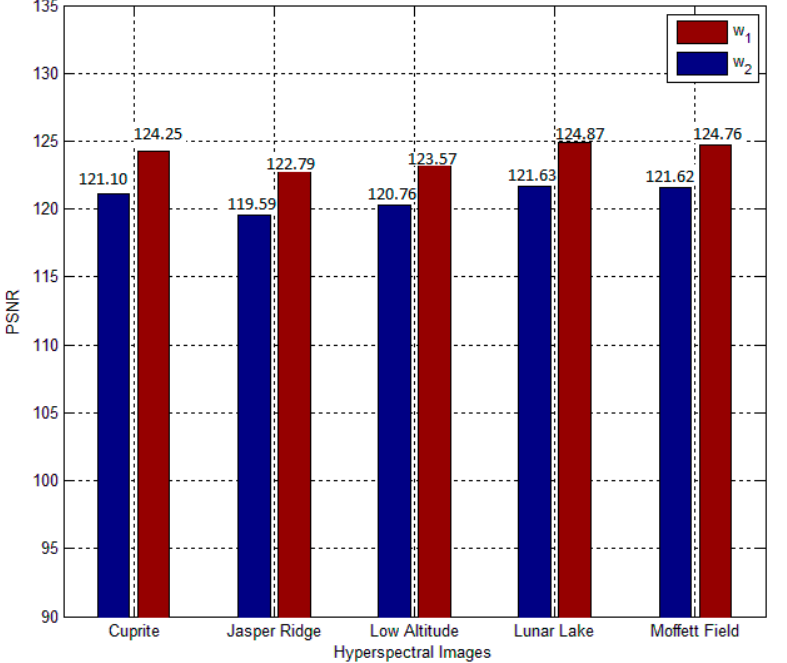
Figure 2. Histogram of the average PSNR achieved for the watermark w 1 and the watermark w 2 (Dataset 1).